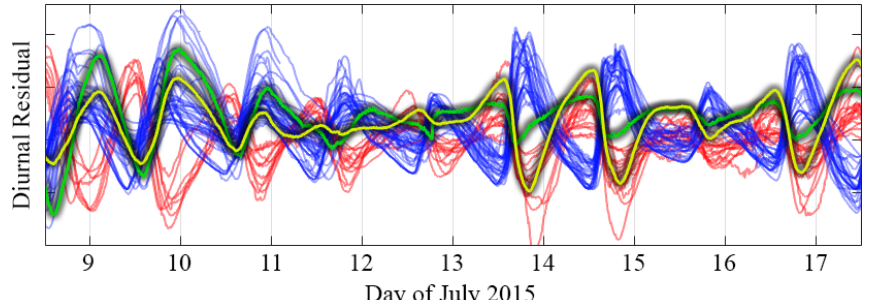
Figure 12. Diurnal residual data between 9 and 17 July 2015 for a hydraulic cluster. Over this period the cluster consisted of 41 correlated boreholes (blue) and 16 anti-correlated boreholes (red). Two additional boreholes (green and yellow lines) transition from correlated to anti-correlated around 12–13 July.